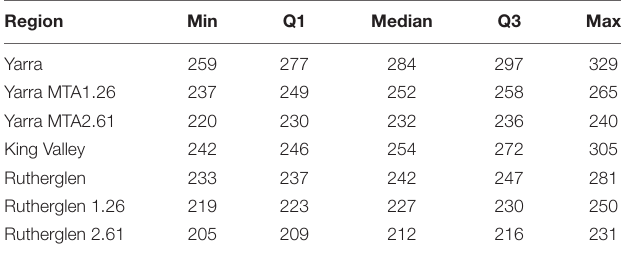
TABLE 5 | Modelled maturity dates (number of days from July 1) for base period 1975–2004 and projected mean temperature anomalies (MTA) of 1.26 and 2.61 ◦ C (after Hall et al.,